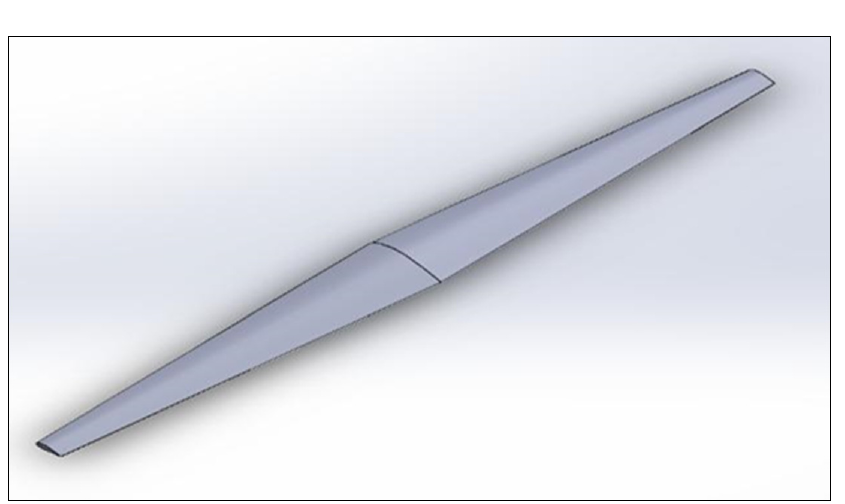
Figure 7. 3D wing model.